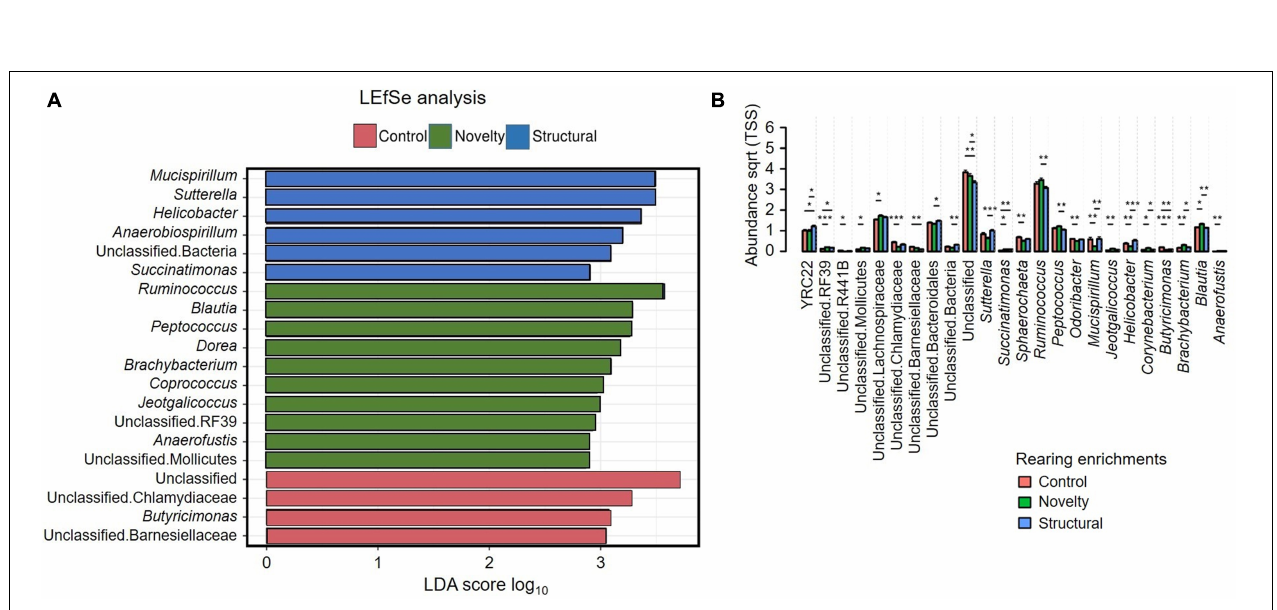
FIGURE 6 | (A) Relative abundance of cecal microbiota of free-range hens at 65 weeks of age from different rearing enrichments (control, novelty, structural) showing linear discriminant analysis (LDA) effect size method (LEfSe). (B) Relative abundance of cecal microbiota of free-range hens at 65 weeks of age from different rearing enrichments (control, novelty, structural) at genus level. One-way ANOVA followed by post hoc comparisons between rearing enrichment groups showed differences * P ≤ 0.05, ** P ≤ 0.01, *** P ≤ 0.001.